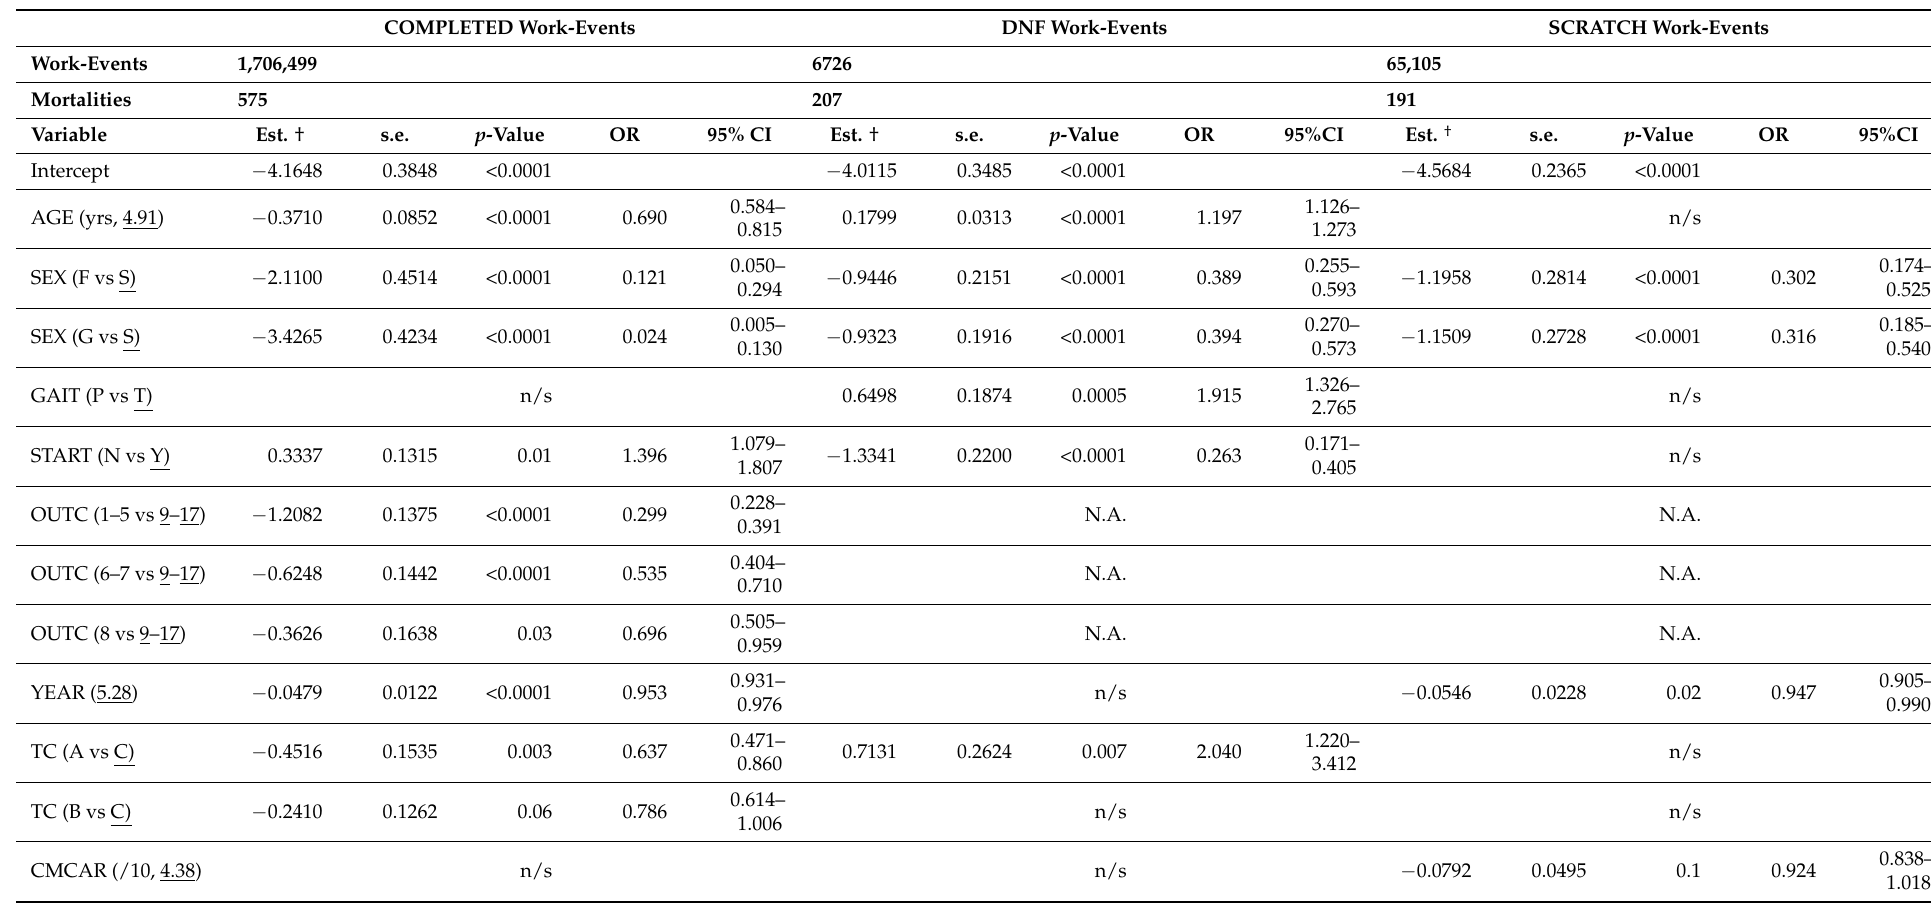
Table 3. Results of Logistic Regression Modelling of Associations with Membership in the Ontario Racing Death Registry (binary response) for Standardbred Work-events for the period 2003–2015—By work-event